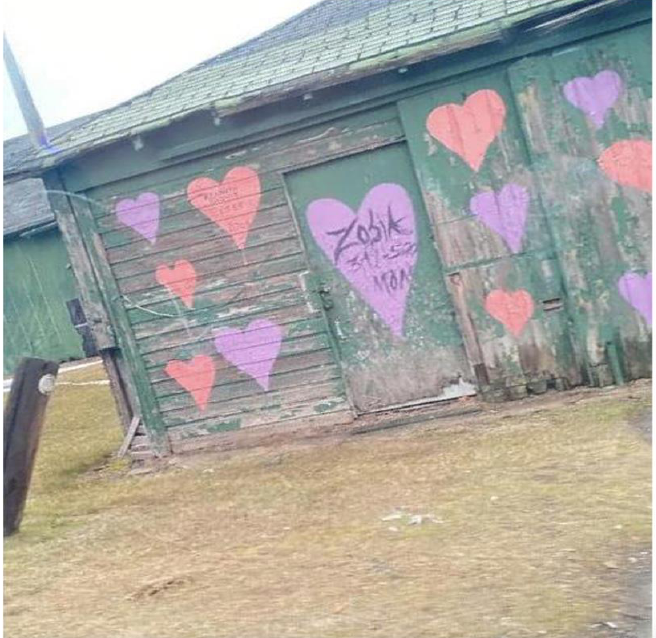
Figure 13. A rundown building with colored hearts representing optimism in the face of challenges.